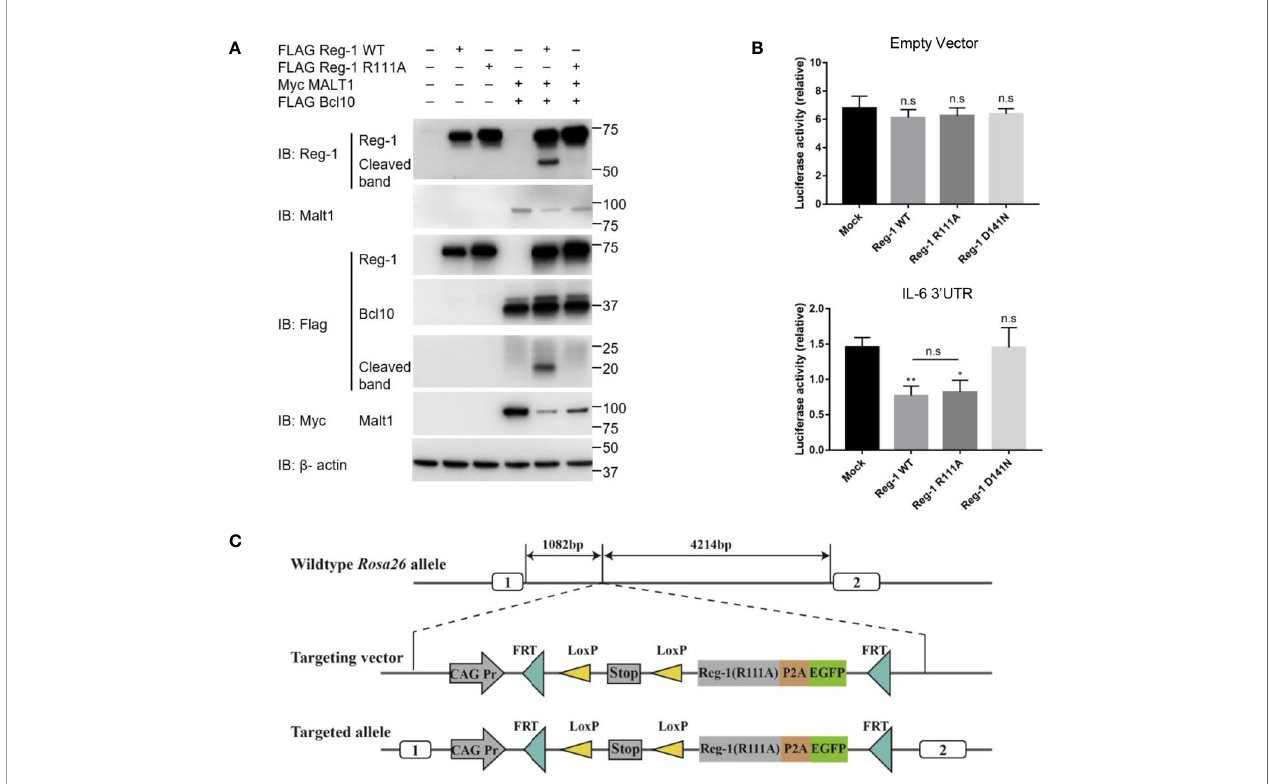
FIGURE 1 | The effects of R111A mutant on Regnase-1 and the strategy of generating Regnase-1(R111A) transgenic mice. (A) Immunoblot analysis of lysates from HEK293 cells transfected with Flag-Regnase-1 (WT or R111A) and/or Myc-Malt1 and Flag-Bcl10 expression plasmids. (B) Relative luciferase activity of HEK293 cells transfected with pmiGLO plasmids and Regnase-1 expression plasmids. (C) Strategy for insertion of the R111A mutant Regnase-1 into the mouse Rosa26 allele. Data are mean ± SD (n=3) from one experiment, representative of three independent experiments. n.s not signi fi cant; * P < 0.05; ** P < 0.01 (one-way ANOVA